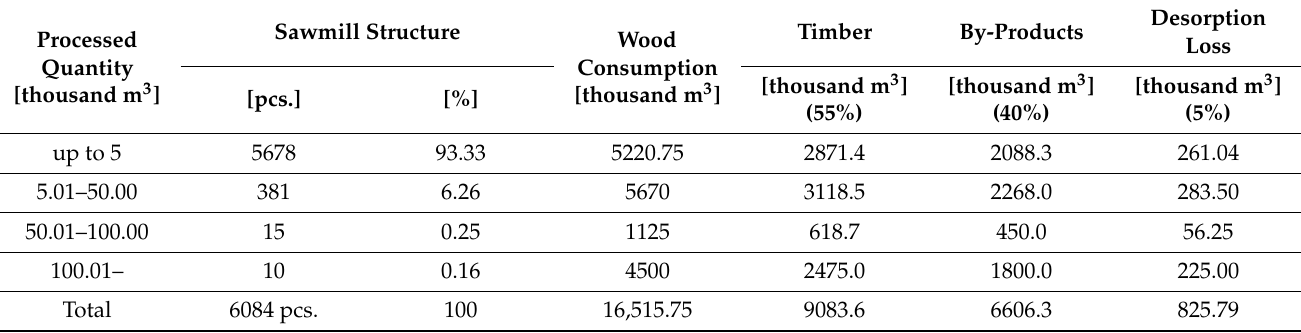
Table 6. Quantity of processed wood and by-products generated in